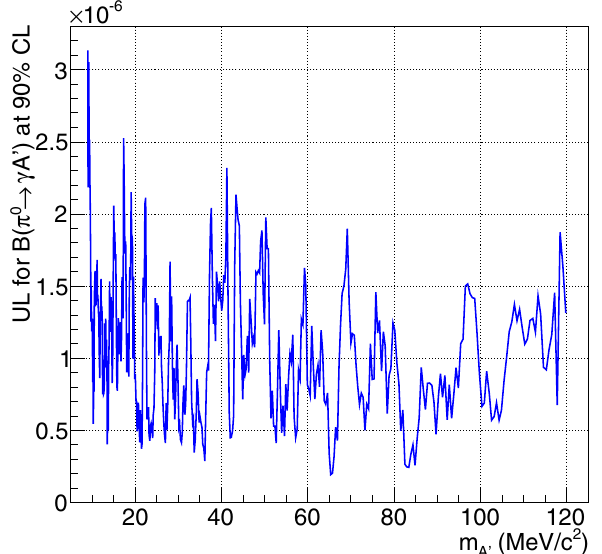
Fig. 39 Upper limits obtained for B (π 0 → γ A (cid:4) ) at 90% CL for each dark photon mass value m A